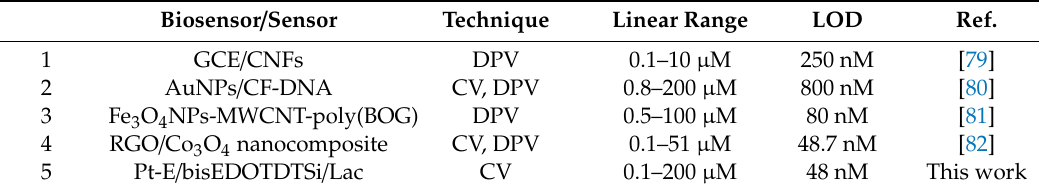
Table 1. Comparison of biosensors and sensors for 5-HT detection.